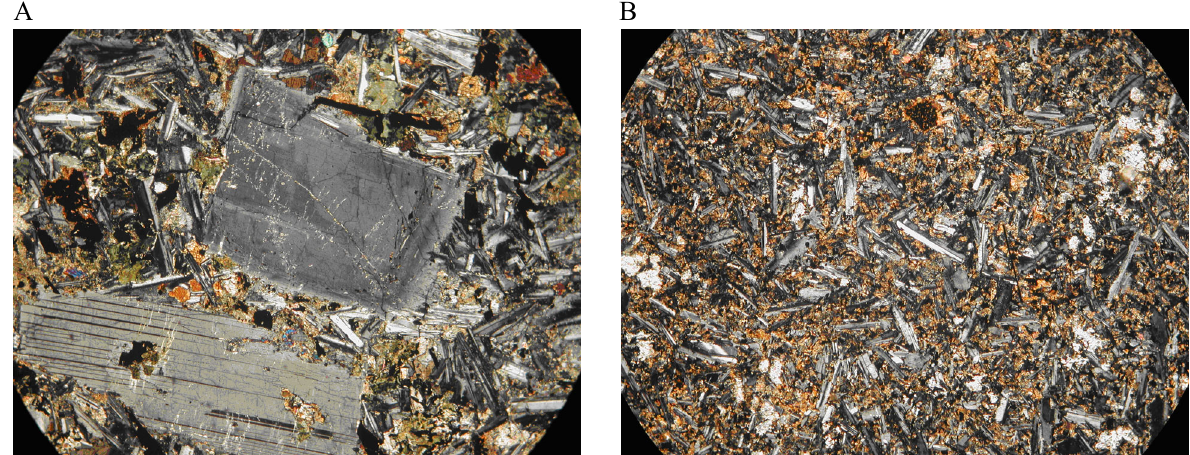
Fig. 3. Microphotograph of the dolerite from well D1-1: A , fine-grained; B , very fine-grained. The base of the picture is 4.5 mm